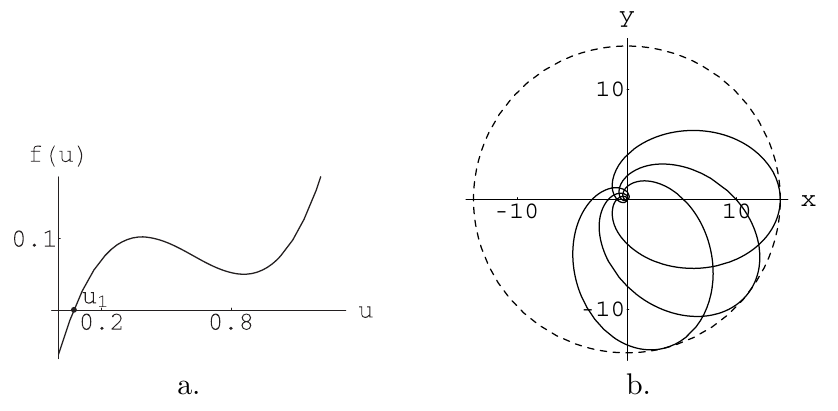
Fig. 7. (a) The cubic f ( u ) and (b) corresponding trajectory for u > u 1 . The graphs are given for σ = 1 . 1 +